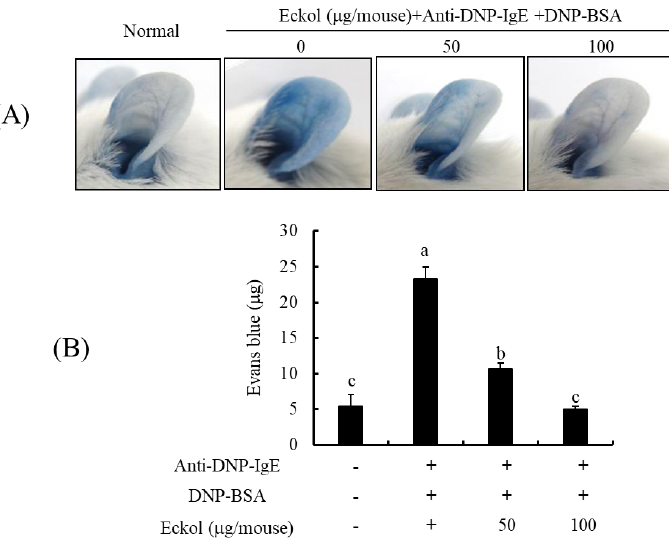
Figure 7. Effect of eckol on the IgE-mediated PCA reaction in mice. ( A ) Representative photographic images of ears, ( B ) Amount of extracted dye. Data are expressed as means ± SD ( n = 3) of three individual experiments. Differences in mean values among groups were assessed by one-way analysis of variance followed by Duncan’s test using PASW statistics 21.0. A value of p < 0.05 was considered statistically significant.